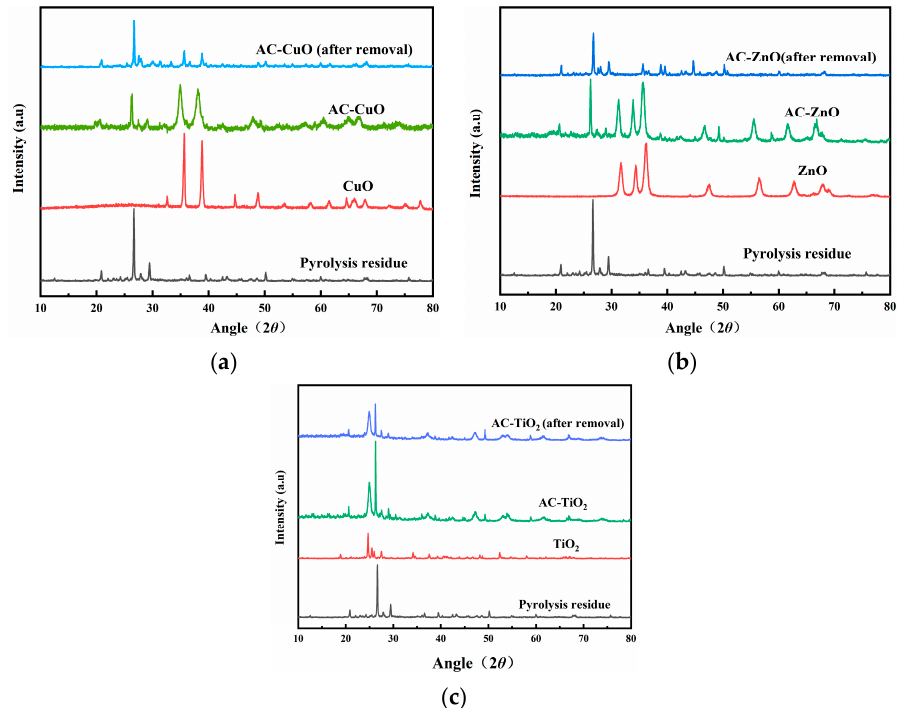
Figure 6. XRD patterns of pyrolysis residue; ( a ) AC-CuO; ( b ) AC-ZnO; and ( c ) AC-TiO 2 . FT-IR